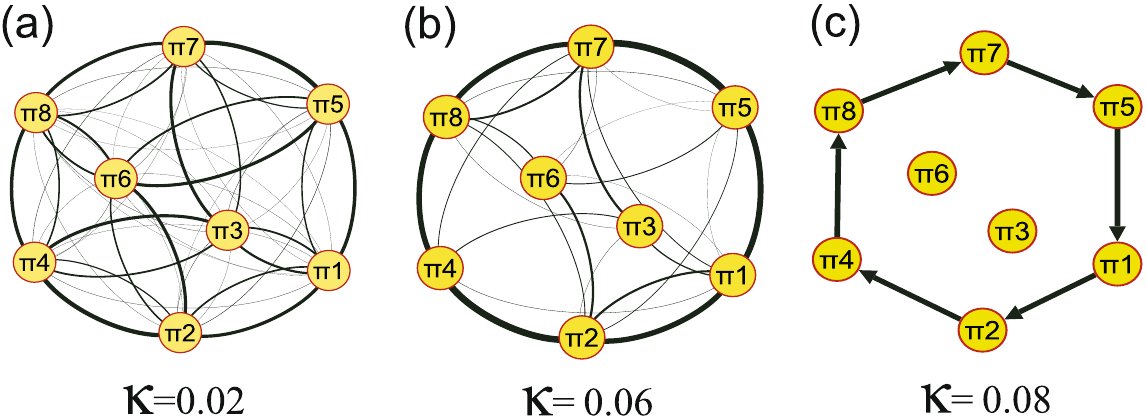
Figure 9. Ordinal transition networks on the path to phase synchronization of Eq. (8), for three typical coupling strength. ( a ) Random transitions in the non-sync regime of κ = 0.02 < κ c 1 , ( b ) dominant structure appears in the regime that oscillators k = 1 and k = 2 are phase synchronized, but not with k = 3, κ = 0.06 ∈ [ κ c 1 , κ c 2 ], ( c ) only one transition route of ordinal patterns is observed when all three oscillators are phase locked κ = 0.08 > κ c 2 . Thickness of links are determined by the associated frequencies in the transition networks and self-loops are removed. In ( a , b ), link arrows are suppressed for the ease of